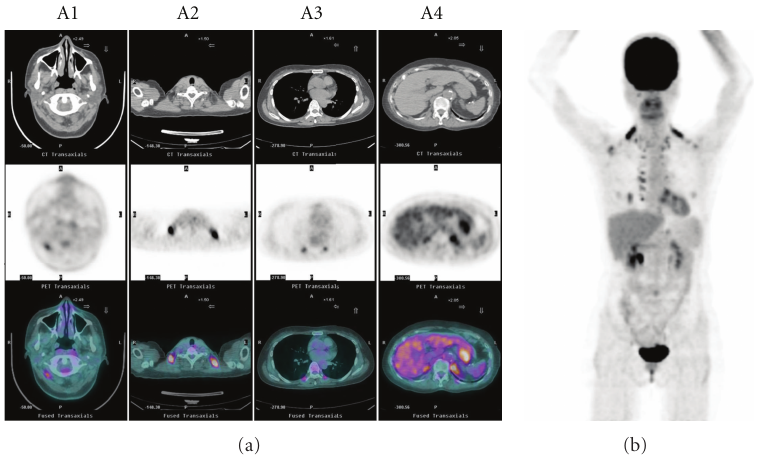
Figure 1: The 18 F-FDG PET/CT scan of a patient with activated BAT displayed on transverse slice of CT (a: upper row), PET (a: middle row), a fusion of PET and CT images (a: lower row), and a maximum intensity projection (b); hypermetabolic BAT deposits of increased 18 F-FDG uptake with a symmetric distribution in the bilateral posterior neck (A1), supraclavicular (A2), paravertebral (A3), and suprarenal (A4)